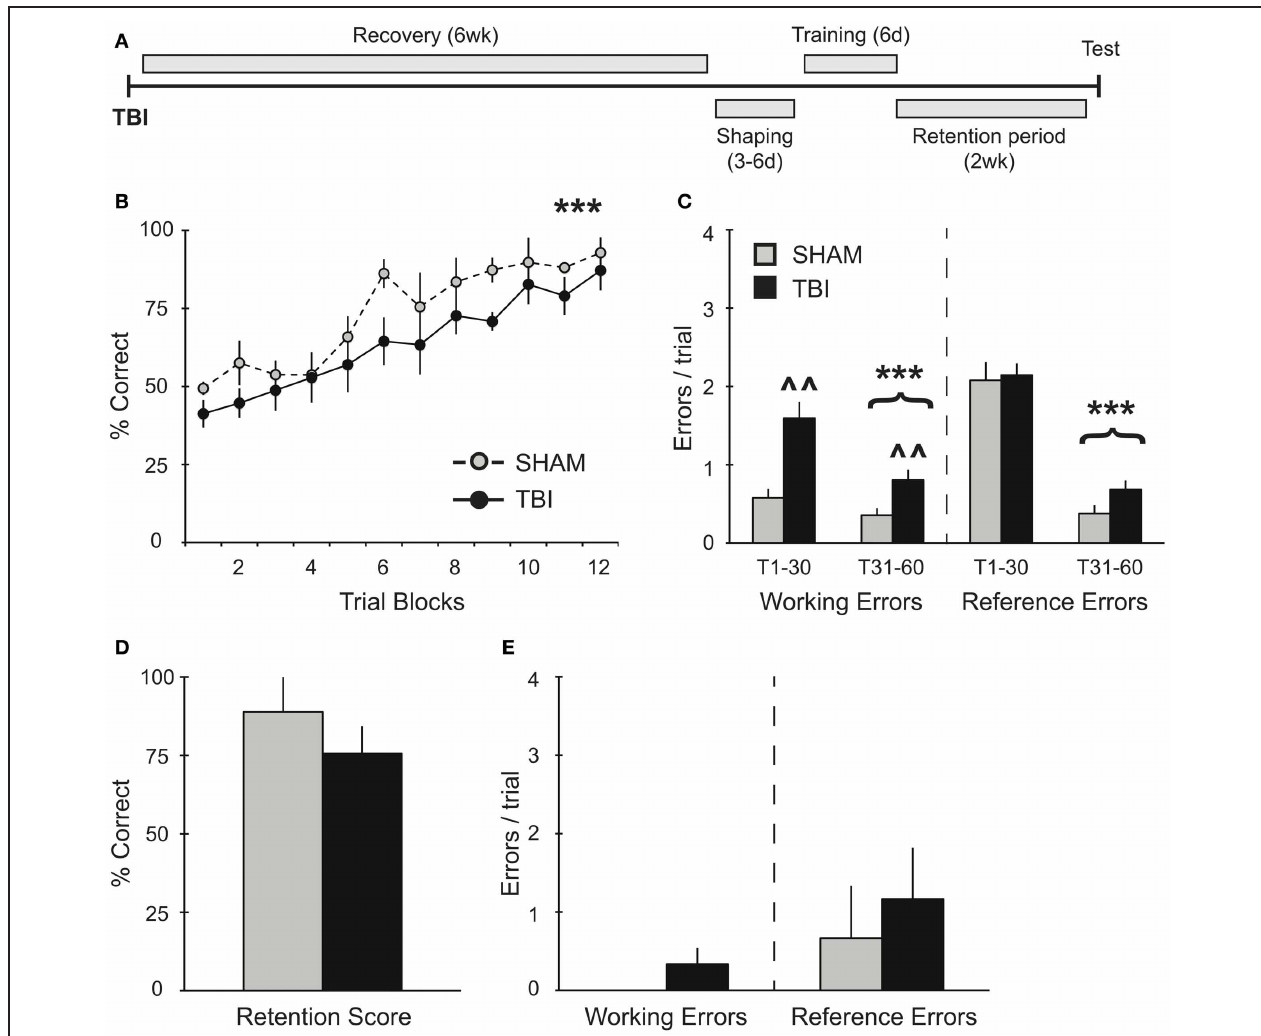
and significant decreases in working and reference memory errors across training days for both groups ( ∗∗∗ p < 0 . 001). There was also a deficit in working memory in the TBI group ( ∧∧ p < 0 . 01). (D,E) During retention testing, there were no significant differences in performance between